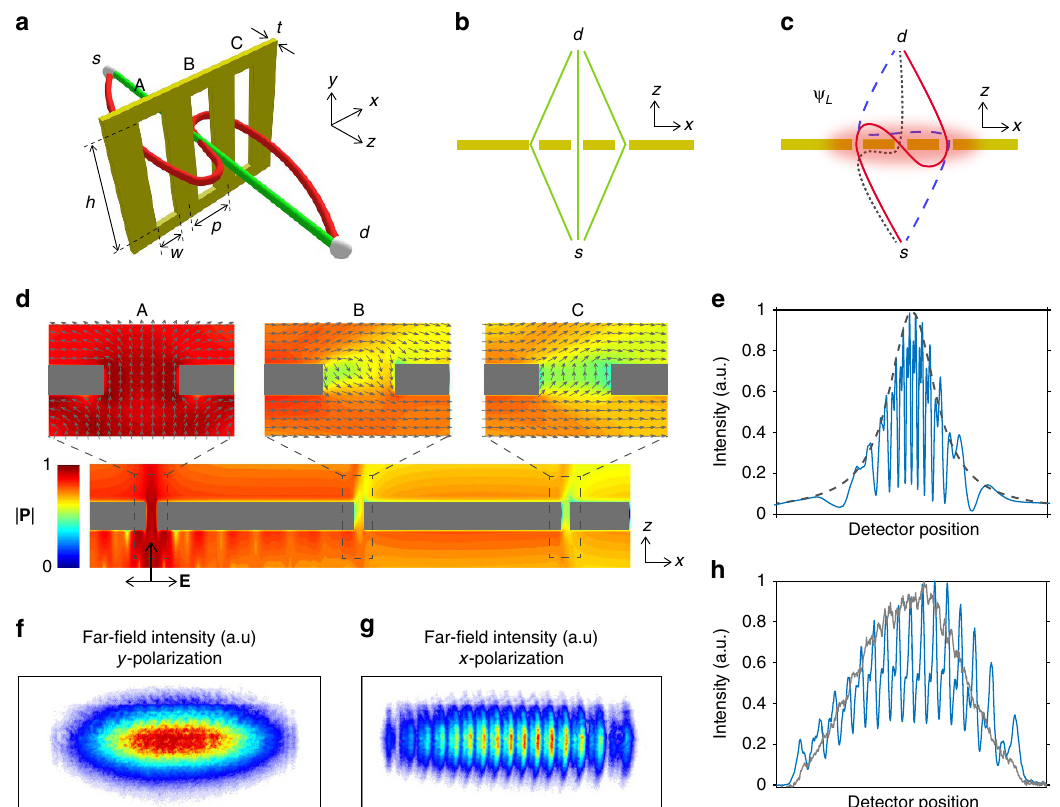
Figure 1 | Trajectories of light in a three-slit interferometer. ( a ) The three-slit structure considered in this study. The red path going from point s to point d illustrates a possible looped trajectory of light. ( b ) Direct trajectories of light resulting from considering only the first term in equation (8). The widely used superposition principle, that is, equation (1), accounts only for these direct trajectories. ( c ) Examples of exotic looped trajectories arising from the higher order terms in equation (8). The red cloud in the vicinity of the slits depicts the near-field distribution, which increases the probability of photons to follow looped trajectories. ( d ) Normalized Poynting vector P in the vicinity of the three slits obtained through full wave simulations at a wavelength l ¼ 810nm, using a slit width w equals to 200nm, slit separation p ¼ 4.6 m m, sample thickness t equals to 110nm, and assuming infinite height, h ¼ N . The simulations consider a Gaussian beam excitation polarized along x , and focused onto slit A. The Poynting vector clearly exhibits a looped trajectory such as the solid path in c . ( e ) Far-field interference patterns calculated under x -polarized (solid) and y -polarized (dashed) optical excitation. Interference fringes are formed in the far field only when strong near fields are excited ( x -polarization), and occur from the interference of light following a direct trajectory and a looped trajectory. ( f ) Experimental evidence that shows the far-field pattern for a situation in which only one slit is illuminated with y -polarized heralded single-photons. ( g ) The presence of exotic looped trajectories leads to an increase in the visibility of the far-field pattern. This effect is observed when x -polarized light illuminates one of the slits. ( h ) The transverse profile of the patterns shown in f , g